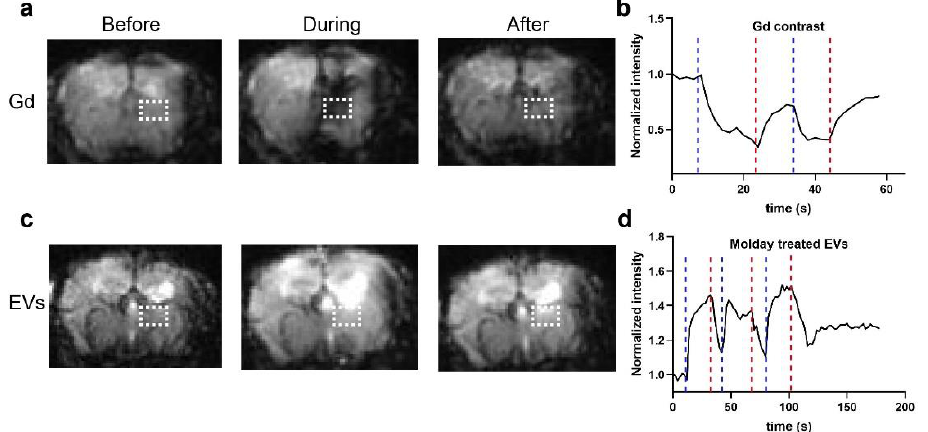
Figure 5. Real-time MRI to observe the EV delivery: ( a ) Representative T2* images before, during, and after infusion of SPIO at a rate of 0.15 mL/min. ( b ) Dynamic signal changes of the two ROIs marked in ( a ). ( c ) Representative T2* images before, during, and after infusion of EVs from Molday ION-treated hMSCs at a rate of 0.15 mL/min. ( d ) Dynamic signal changes of the two ROIs marked in ( c ).